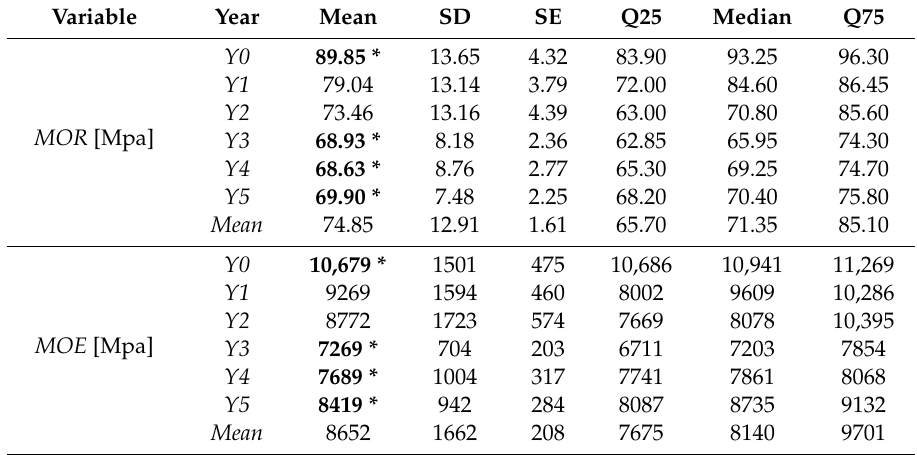
* differences statistically significant at the significance level p < 0.05 are marked.